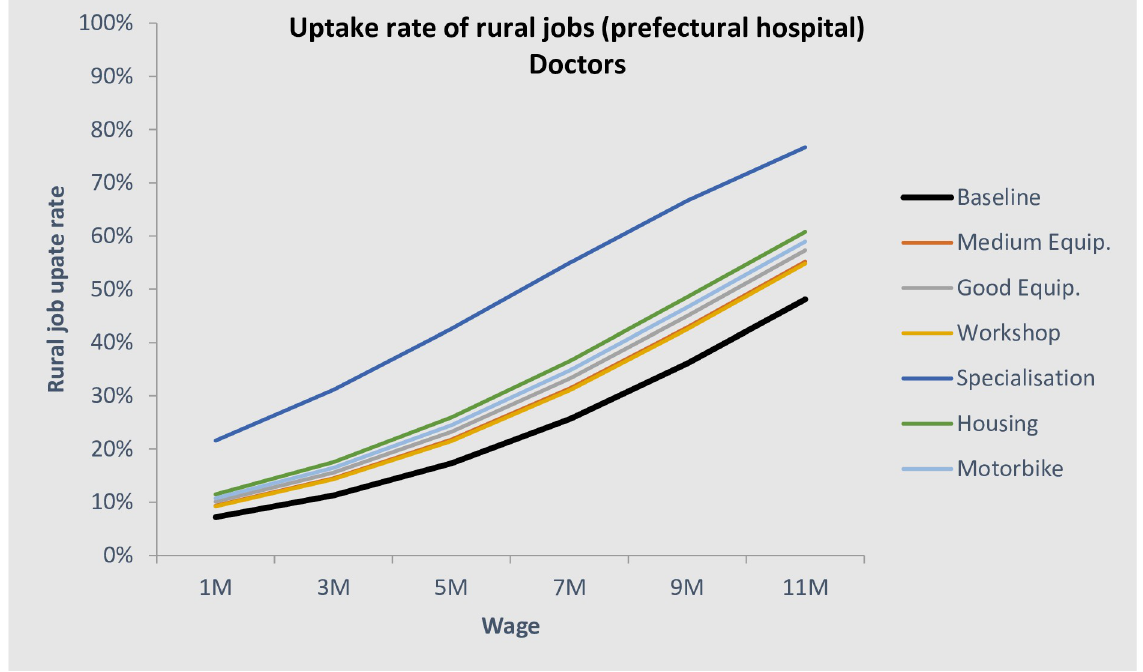
Fig 6. Uptake rate of prefectural posts for doctors.